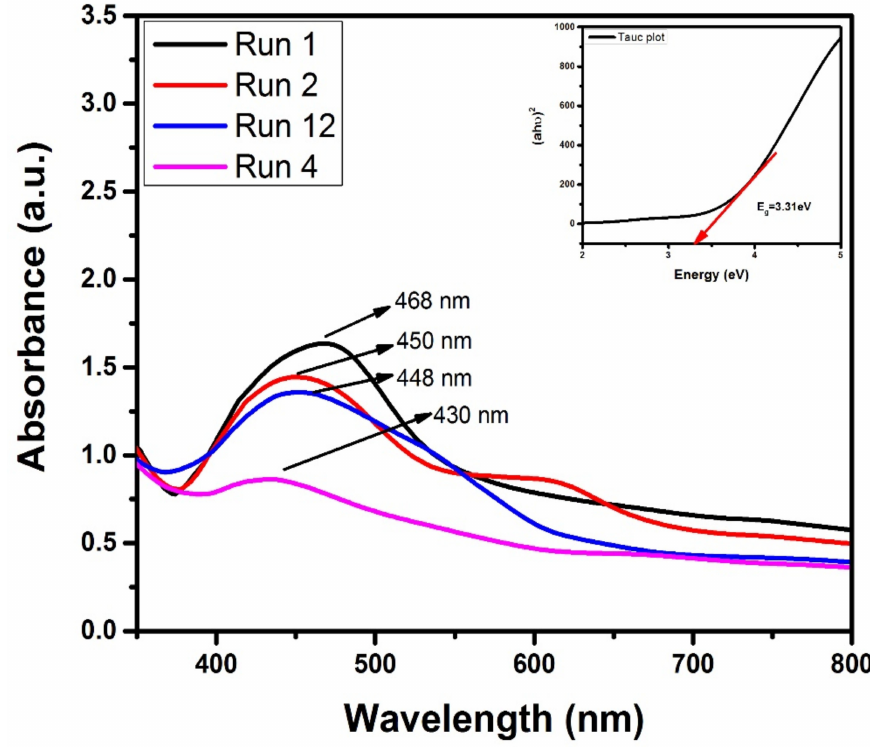
Figure 6. Variation in the UV-absorption peak with different process